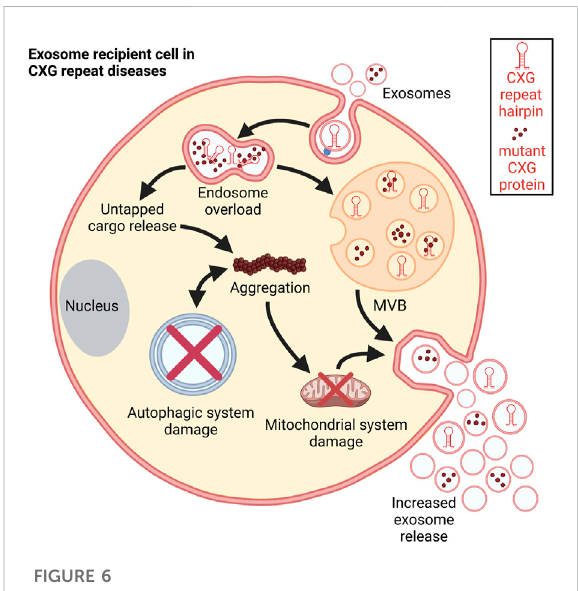
FIGURE 6 Schematic representation of the consequences of exosomal uptake. Post internalization, the disease-speci fi c exosomal cargo overloads the endosome leading to untapped cargo release into the cytosol. This cargo could disrupt different cellular processes. It promotes aggregation and damages the mitochondrial system thereby increasing exosome release. Autophagic processes are impaired in CXG repeat disorders which facilitates further aggregation. These aggregations further push autophagic system collapse (Cortes and La Spada,